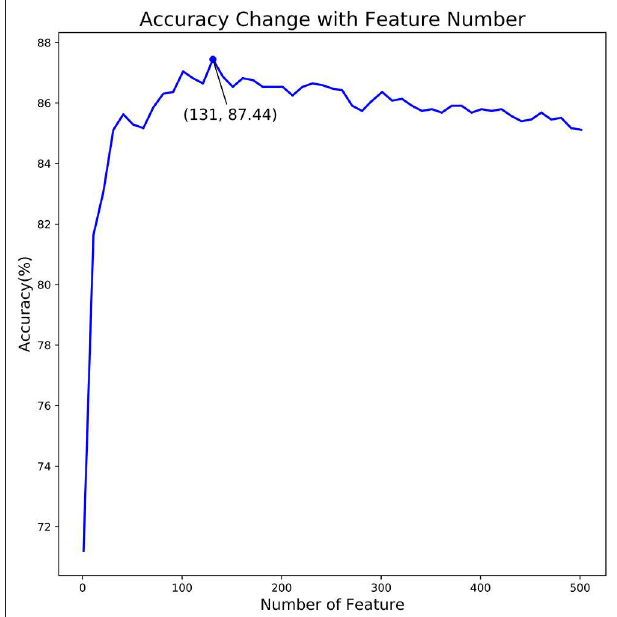
FIGURE 3 | The relationship curve of prediction accuracy and dimension of feature subset. The curve in this figure reflects the change of predictor accuracy with dimension of feature